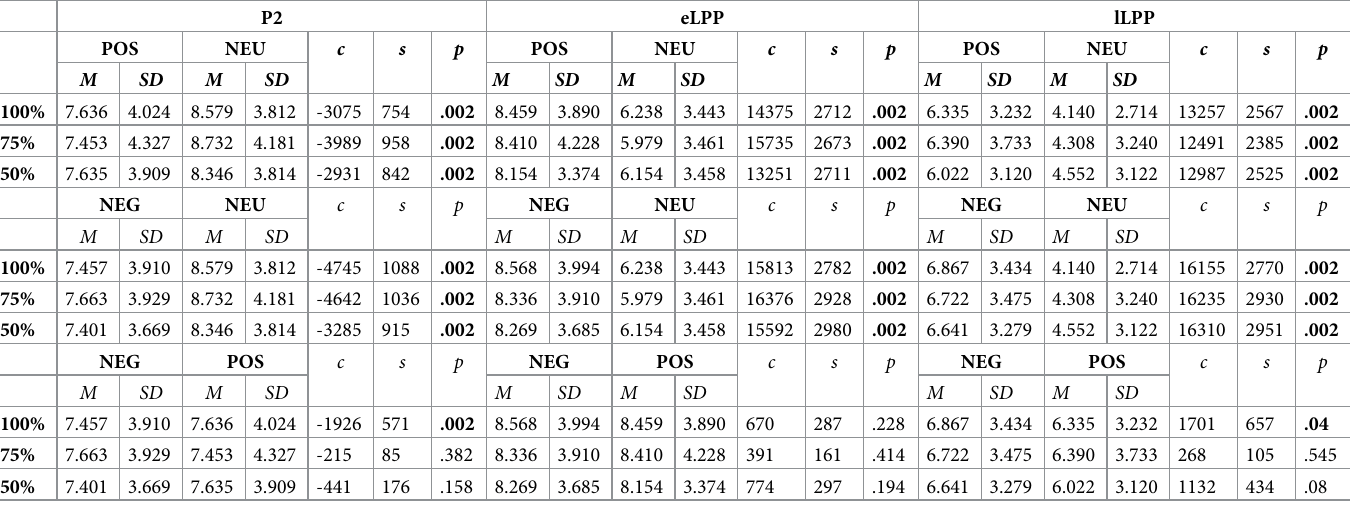
Table 1. Results of planned comparisons in the prediction updating